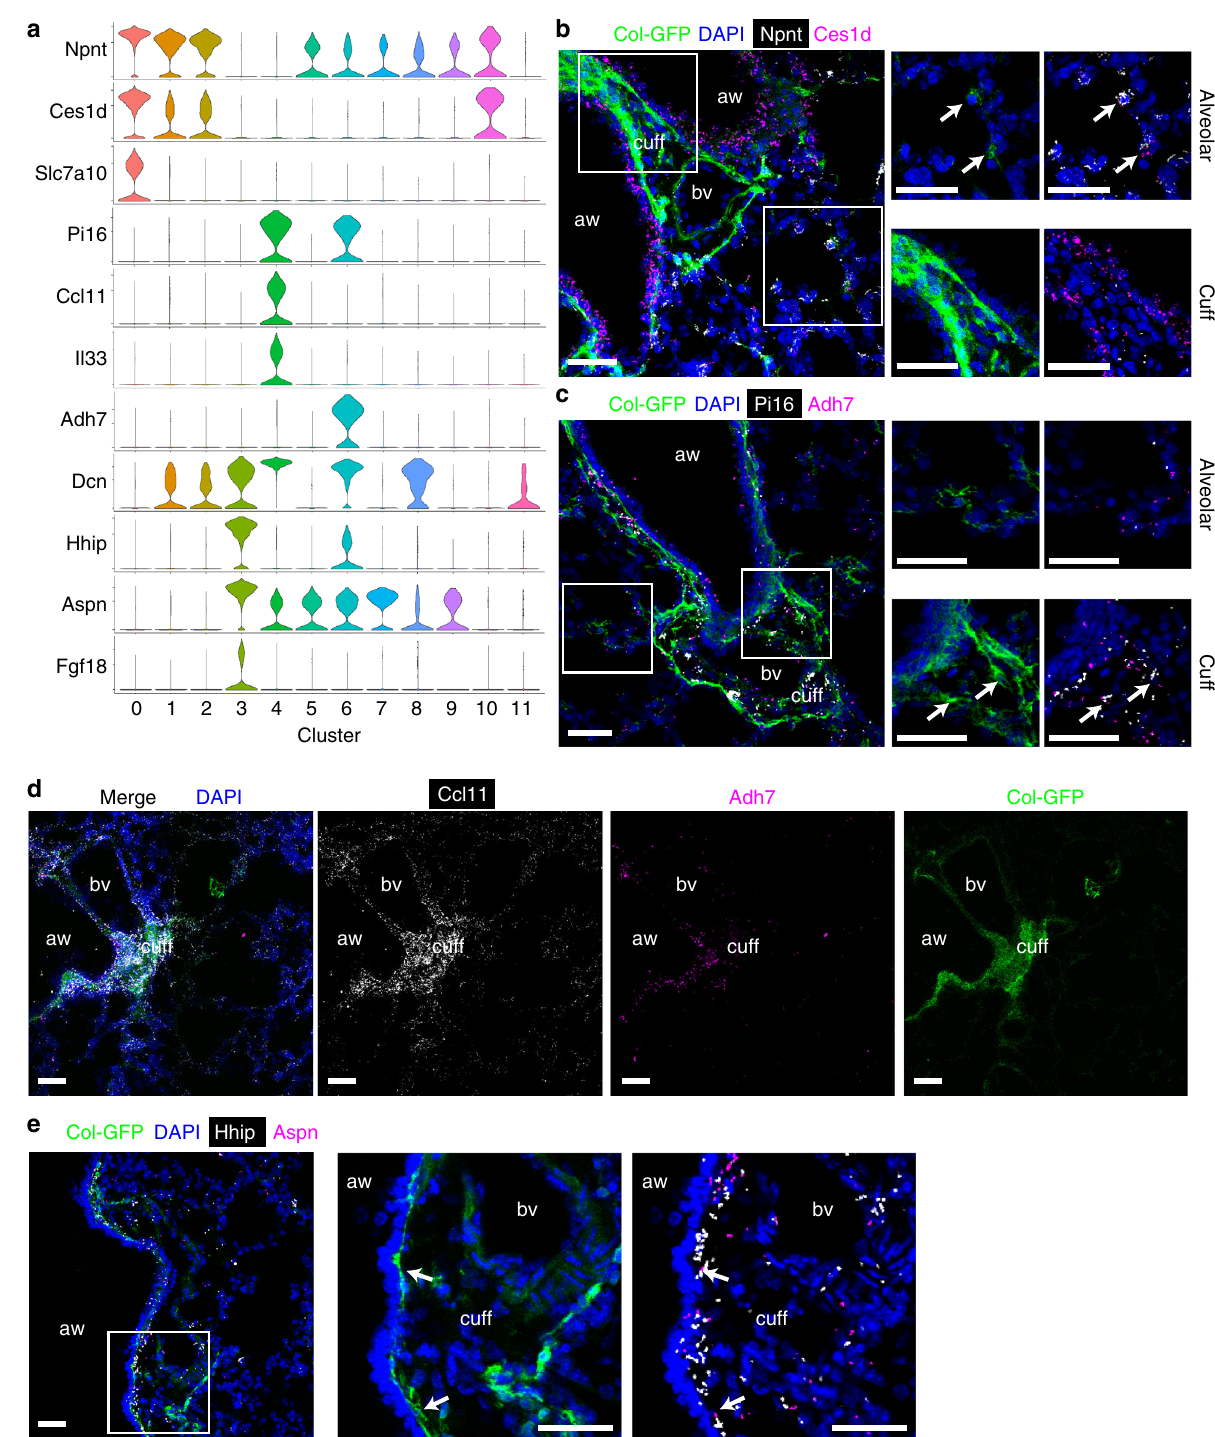
Fig. 2 Identi fi cation of alveolar, adventitial, and peribronchial fi broblasts in untreated lungs. a Violin plots showing the expression levels in each cluster of representative marker genes. b , c Proximity ligation in situ hybridization (PLISH) images for Npnt (white) and Ces1d (magenta) ( b ), or for Pi16 (white) and Adh7 (magenta) ( c ). Magni fi ed images of the white squares are shown in right panels. Arrows indicate co-localization of PLISH signals in GFP + cells. d PLISH images for Ccl11 (white) and Adh7 (magenta). e PLISH images for Hhip (white) and Aspn (magenta). Magni fi ed images of the white square are shown in right panels. Arrows indicate co-localization of PLISH signals in GFP + cells. b – e Col-GFP is shown in green. DAPI signal is shown in blue. Scale bars, 50 μ m. aw, airway; bv, blood vessel; cuff, cuff space. Images are representative of three experiments ( n ≥